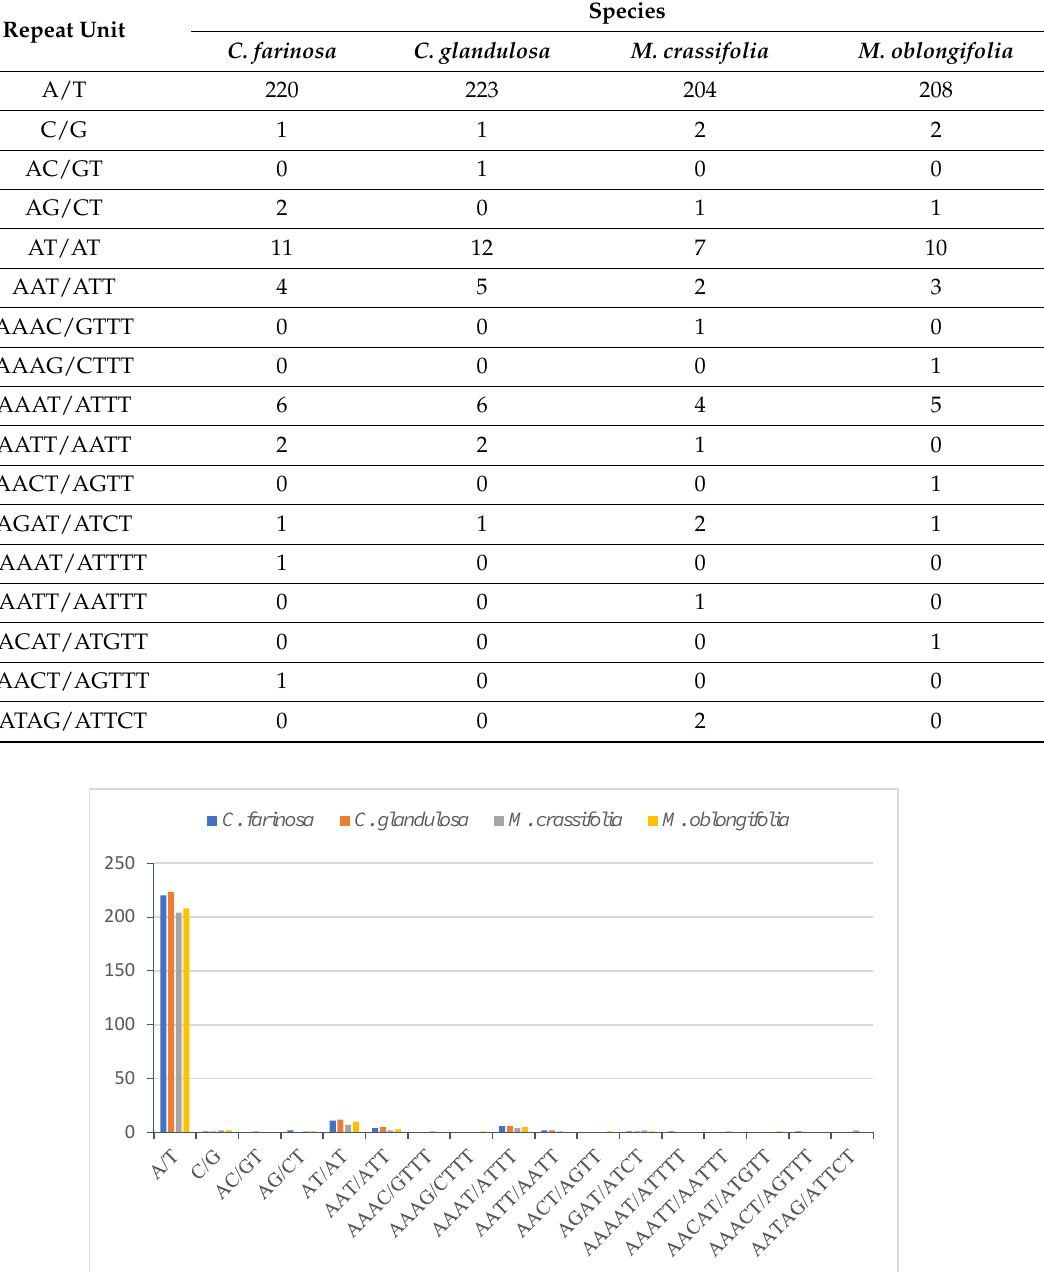
Figure 4. Frequency of different SSR motifs in different repeat types in C. farinosa , C. glandulosa , M. crassifolia and M. oblongifolia chloroplast genomes. Table 3. Simple sequence repeats in the C. farinosa , C. glandulosa , M. crassifolia and M. oblongifolia chloroplast genomes.